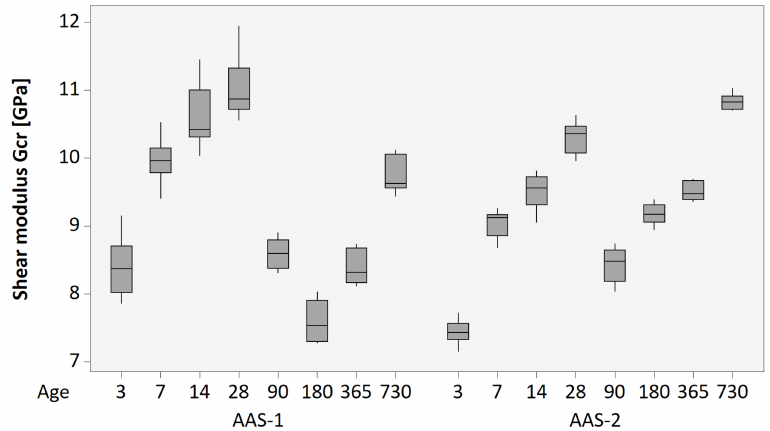
Figure 5. Box plot of the development of the Young’s modulus G